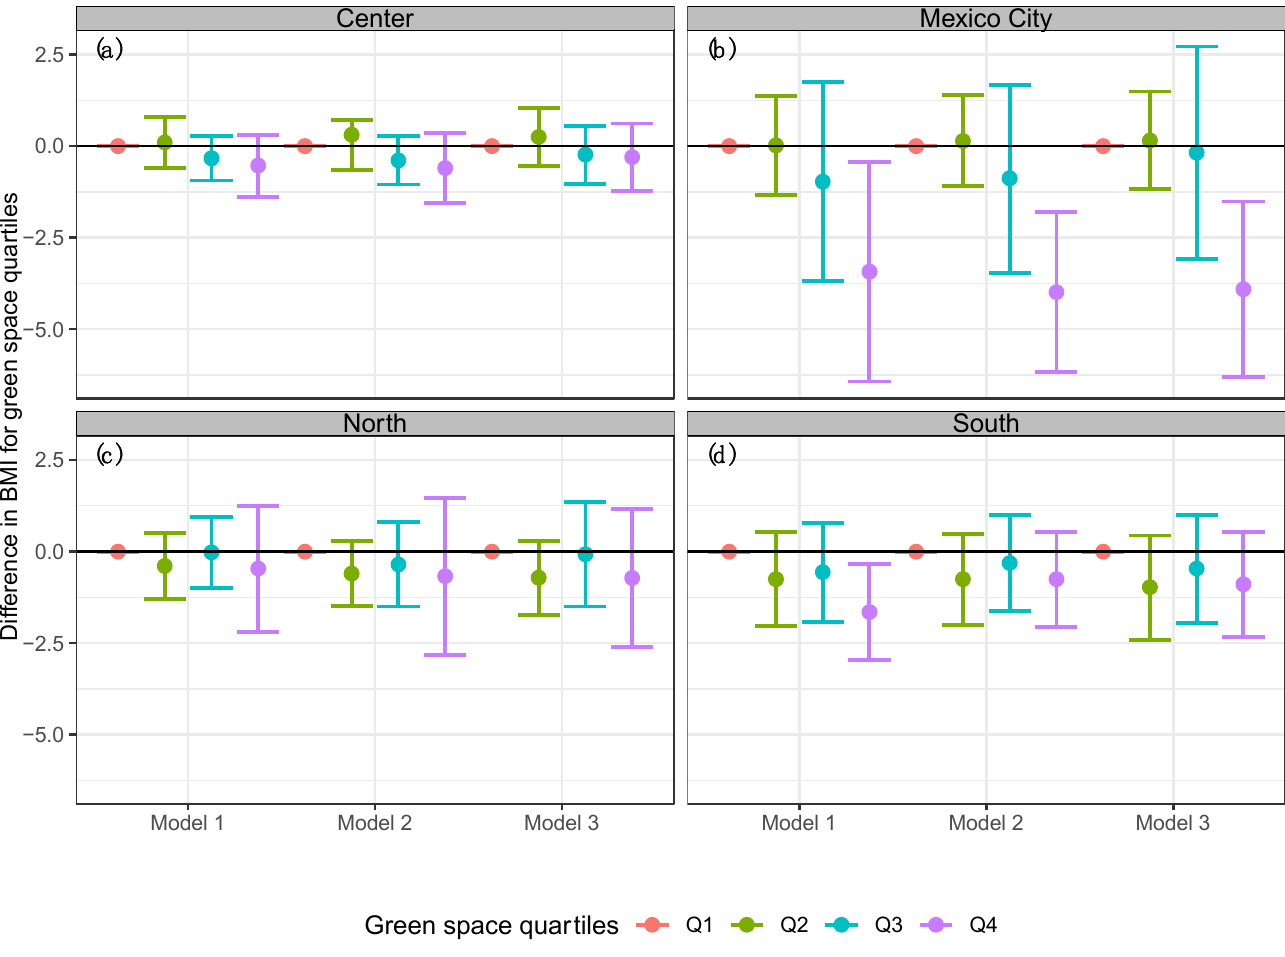
Figure 6. Linear models stratified by region for BMI in the Mexican adult population by the difference quartiles of NDVI. ( a ) Center, ( b ) Mexico City, ( c ) North, and ( d ) South. Model 1 = Linear regression model for BMI and NDVI stratified by region. Model 2 = Adjusted linear regression model for BMI, NDVI, age, sex, area, socioeconomic status and education level stratified by region. Model 3 = Adjusted linear regression model for BMI, NDVI, physical activity, age, sex, area, socioeconomic status and education level stratified by region.